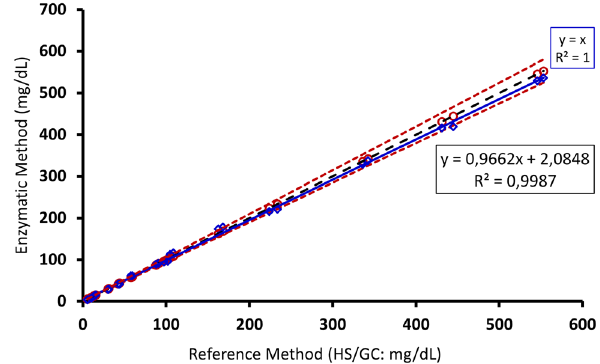
Figure 3: Passing-Bablok chart of the enzymatic and HS/GC